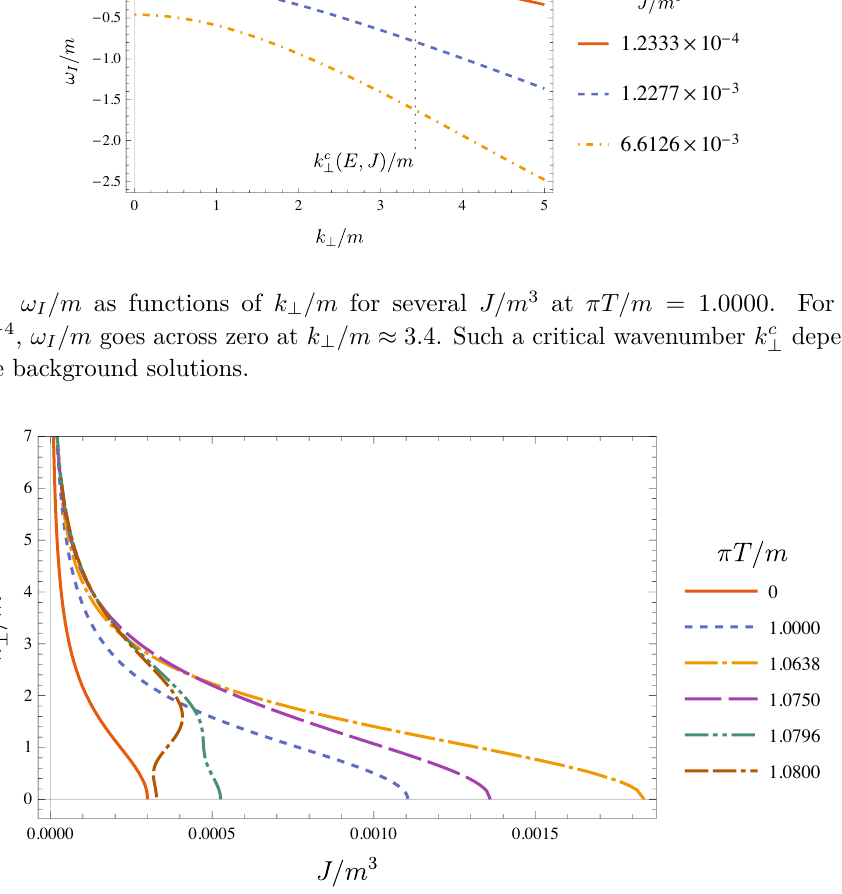
/m vs J/m 3 at various temperature. For πT/m ≥ 1 . 0796 , k c ⊥